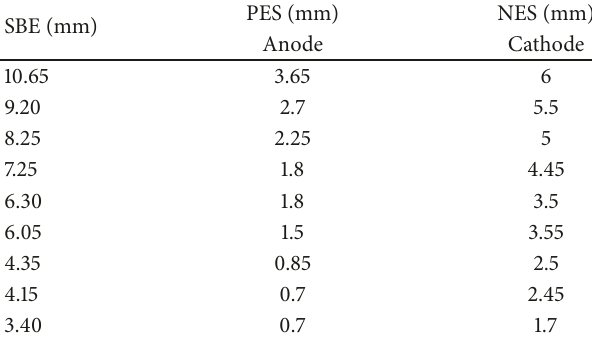
Table 2: Total space between electrodes (SBE) analysed, spaces between the surface of the electrodes, and the surface of the separator.